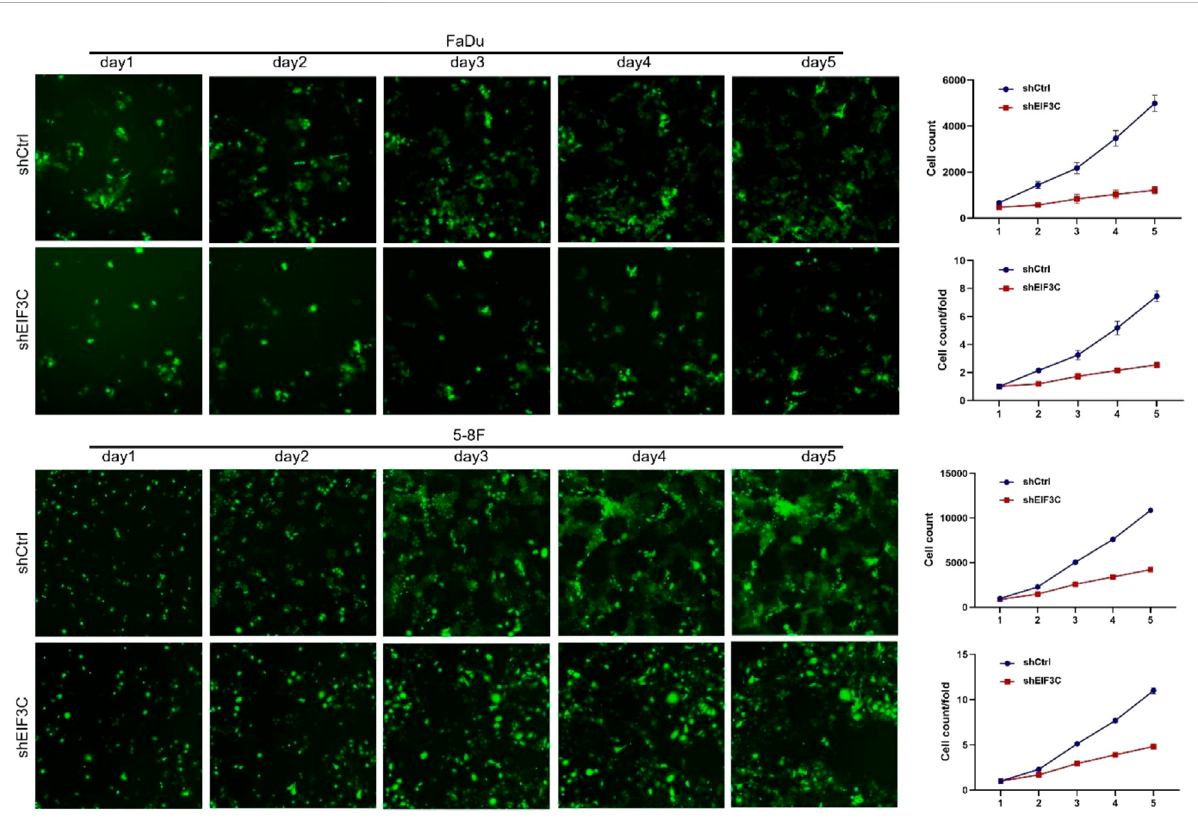
FIGURE 2 The L.v-shEIF3C inhibited the proliferation of FaDu and 5-8F cells in cell growth assay. For fi ve consecutive days, the images and the statistics exhibited that the number of cells with fl uorescence in the L.v-shEIF3C group was less than that in the L.v-shCtrl group. The differences were statistically signi fi